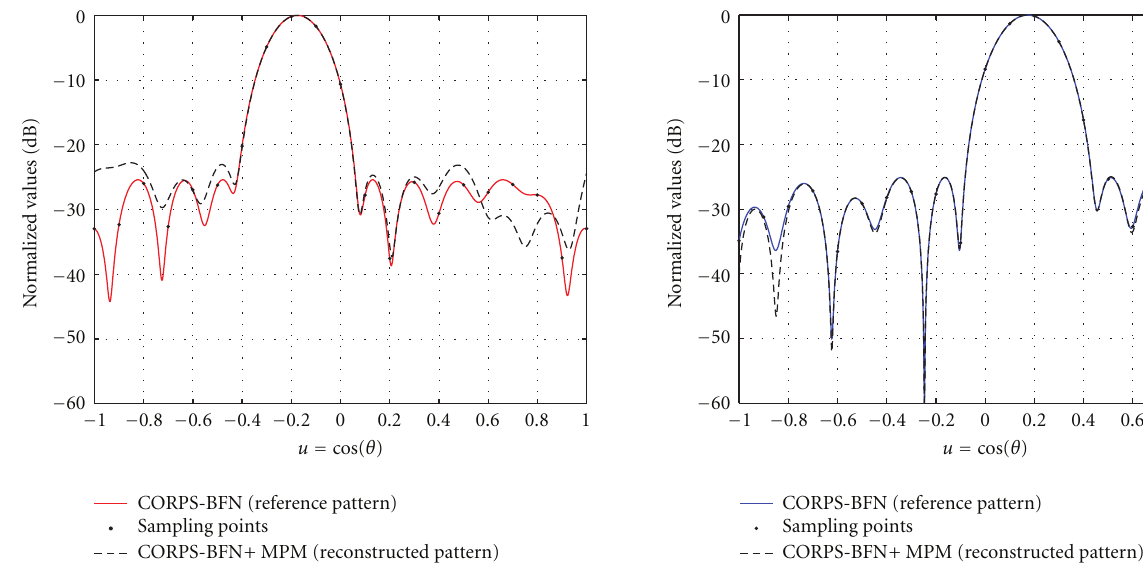
Figure 5: Comparison between the reference factor (CORPS-BFN) and the reconstructed factor (MPM + CORPS-BFN) obtained by the configuration 1 of the CORPS-BFN, showing an example of the beam no. 2 directed at 80 ◦